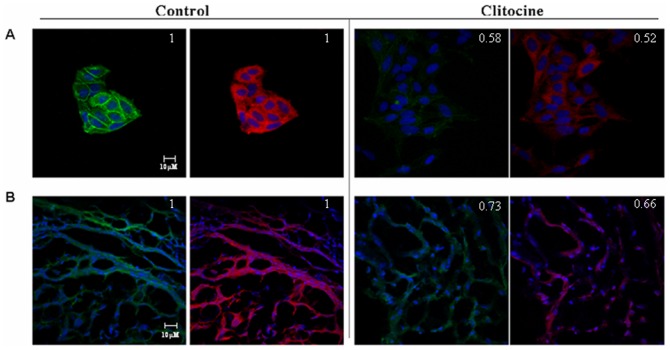
Clitocine inhibits the expressions of NF-κB p65 and P-gp in R-HepG2 cells in vitro and in vivo tumor tissue from nude mice.(A) After treatment with 0.2 µM clitocine for 48 h, immunocytochemistry assay was perpormed in R-HepG2 cells using antibodies: NF-κB p65 and P-gp. (B) After intravenous injection of clitocine (10 mg/kg, once a day for one week), tumors were excised from tumor bearing animals. Tumors were fixed with 4% paraformaldehyde in PBS and cut into 6 µm frozen sections and immunocytochemistry assay was performed. The expression levels of these two proteins were observed with a LSM 510 fluorescence microscope fitted with appropriate filters and the images captured with an Orca II CCD camera (Hamamatsu, Bridgewater, NJ). The pixel intensity was analyzed with Image J. A representative experiment was shown.